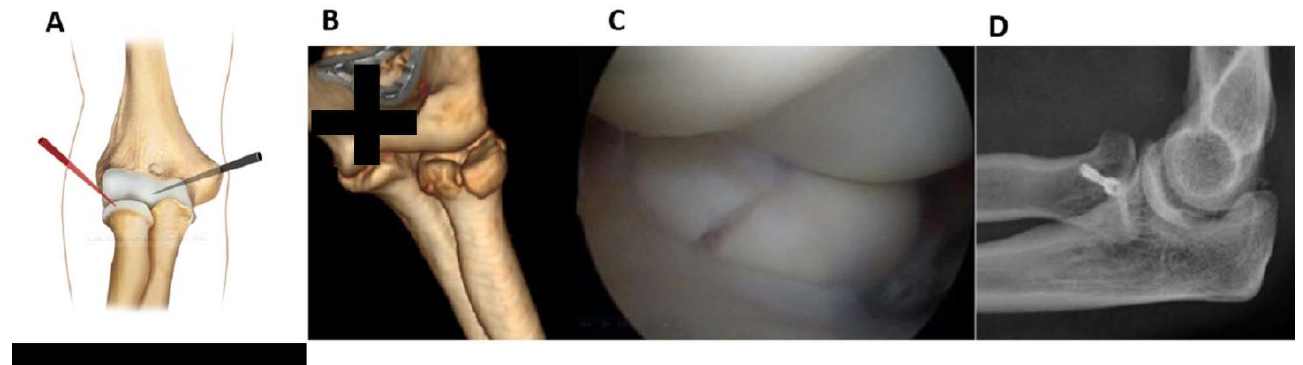
Figure 1. Fractures of the lateral half can be fixed from the anterolateral working position ( A ) . ( B ): pre-operative 3D CT scan showing the fracture. ( C ): intraoperative image of fracture fixation. ( D ): Control x-ray.